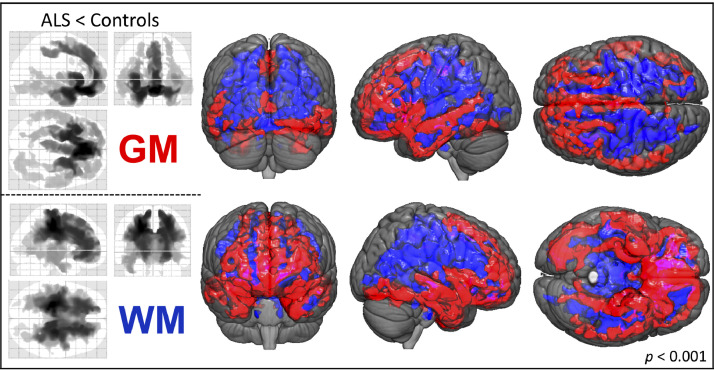
Between-group differences for patients and healthy controls.VBM between-group comparisons of patients (n = 85) and controls (n = 62) revealed GM density decreases (upper 3 glass-brain images, red-labeled in 3D-pictures) mainly outside the motor areas, i.e. within the bilateral frontal and temporal lobes. Observed WM density decreases in ALS patients (lower 3 glass-brain images, blue-labeled in 3D-pictures) encompassed major parts of the frontal structures and parietal projections underlying the motoric and somatosensoric cortices and extended throughout the brainstem. (TFCE; FWE corrected p < 0.001; nuisance co-variates: age, gender, total intracranial volume)Abbreviations: GM: Gray Matter; TFCE: Threshold-Free Cluster Enhancement; FWE: Family-Wise Error; VBM: Voxel-Based Morphometry; WM: White Matter.